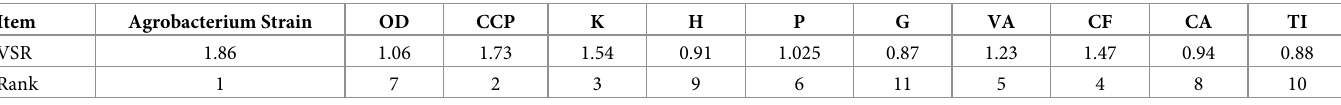
Table 3. The results of sensitivity analysis on the developed ensemble model to rank the importance of factors involved in Agrobacterium -mediated gene transfor- mation of chrysanthemums using GUS gene. Item Agrobacterium